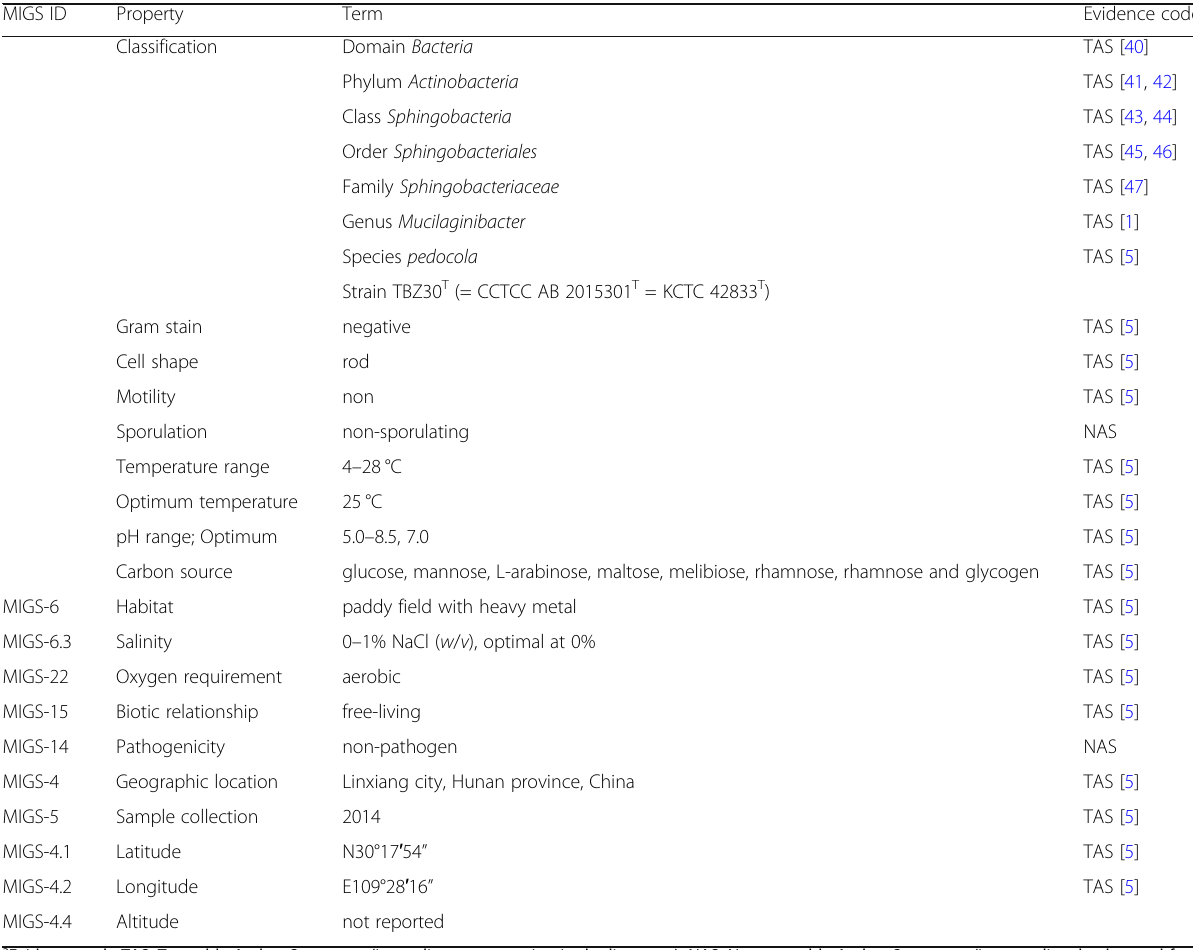
Table 1 Classification and general features of Mucilaginibacter pedocola TBZ30 T [39]